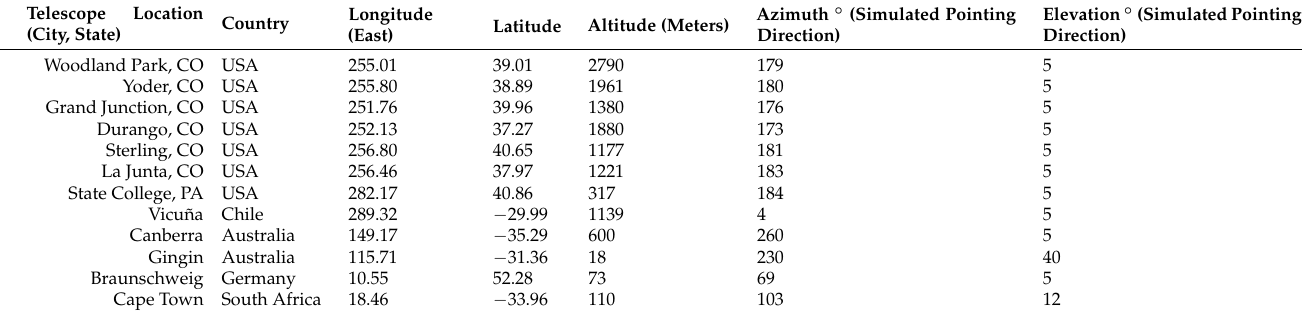
Table 1. Location of the observatories of the FTN [18] with their simulated pointing directions. Telescope Location (City, State)